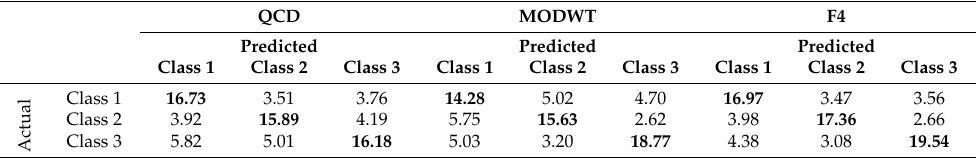
Table 2. Average confusion matrices for the individual (QCD and MODWT) and combined (F4)